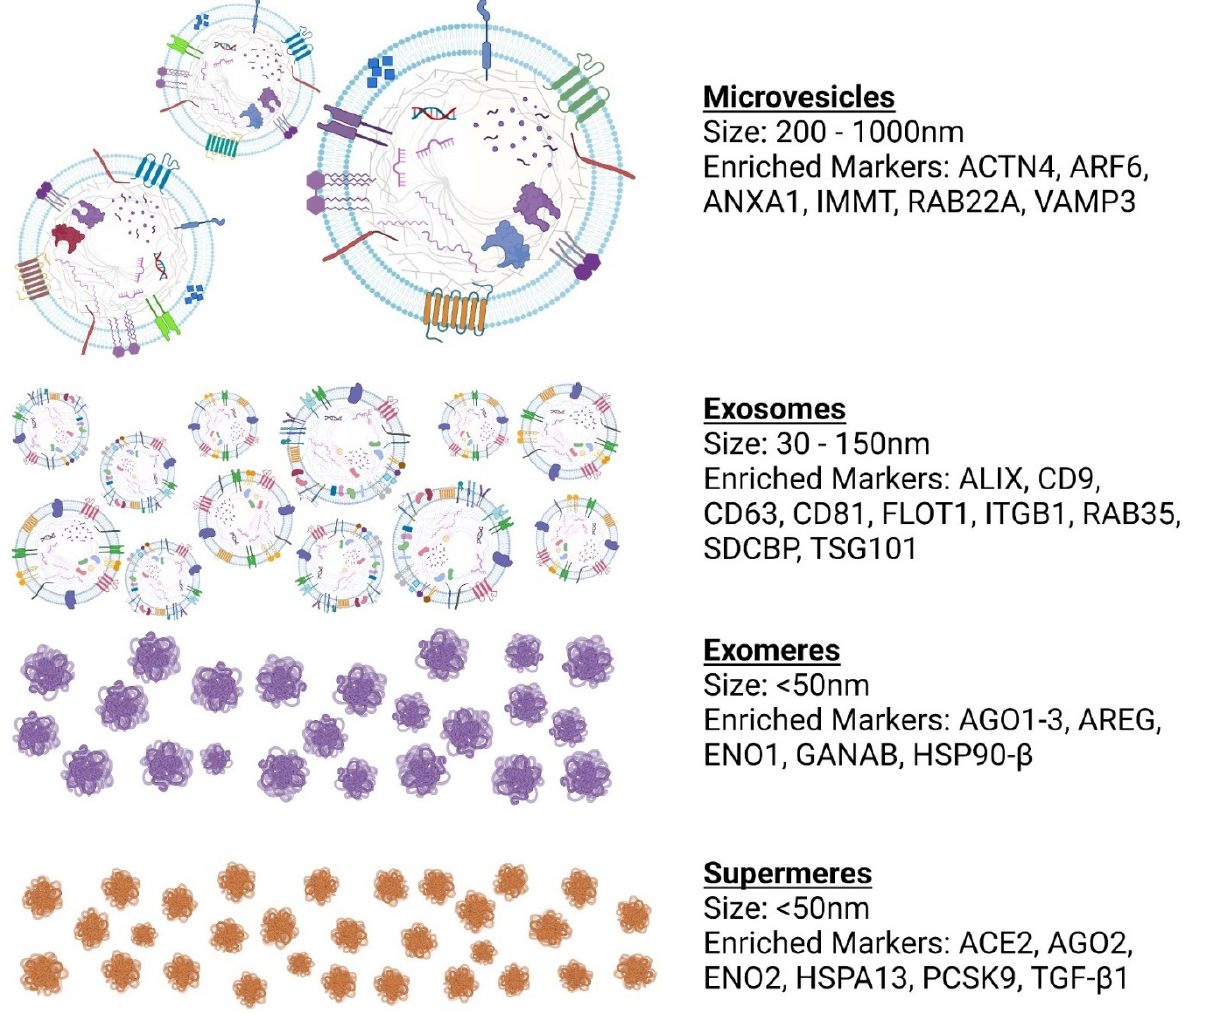
Figure 2. A schematic overview of different extracellular vesicles (EVs) types that include microvesi- cles, exosomes, exomeres, and supermeres. Microvesicles are typically formed by the outward budding of the plasma membrane. Exosomes are derived from multivesicular bodies (referred to as intraluminal vesicles) during formation and can be derived from the cell surface. The biogenesis of exomeres and supermeres remain unknown and are complexes of proteins and nucleic acids that are not membrane enclosed. Collectively, each of these EVs types are enriched in distinct markers that currently defines their composition.